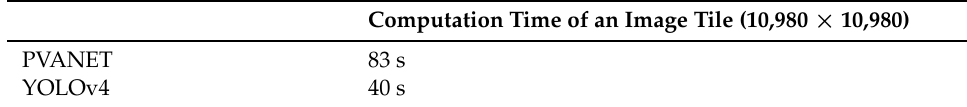
Table 3. Computation time of the detection of PVANET and YOLOv4.